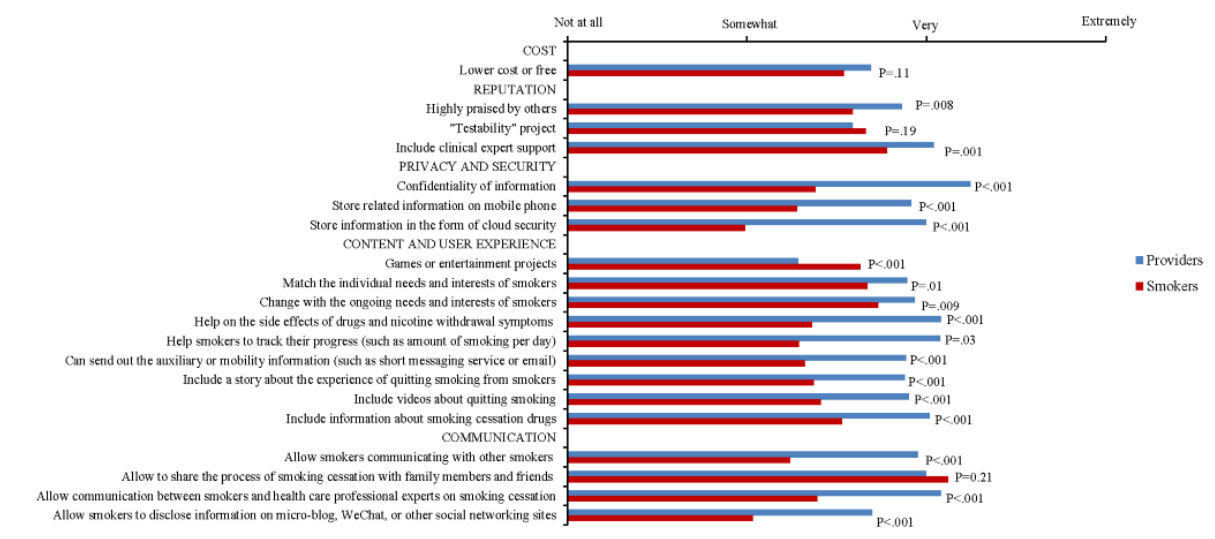
Figure 1. Comparison of providers’and smokers’ratings of important